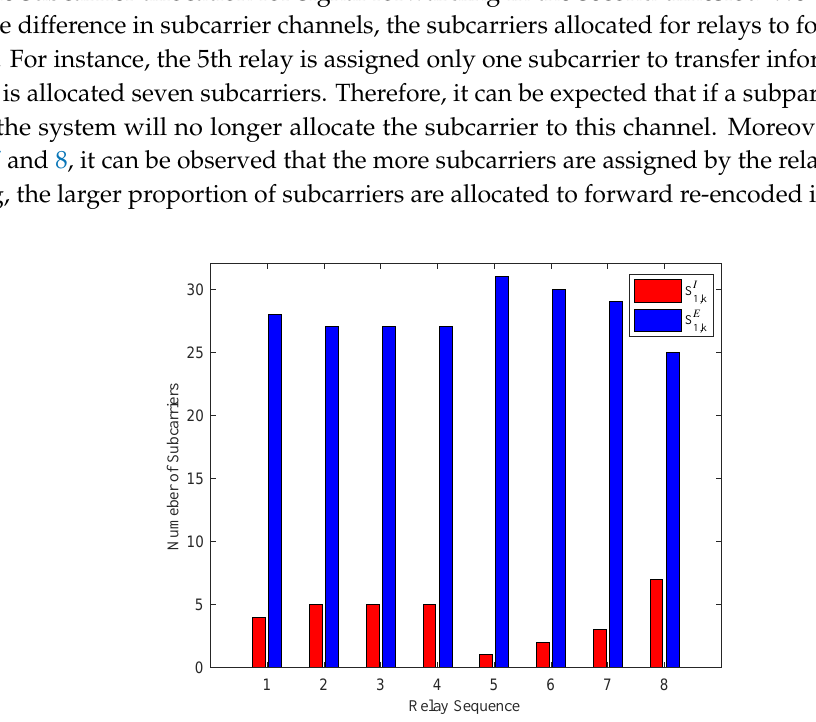
Figure 7. Subcarrier allocation for energy harvesting and information decoding in the first